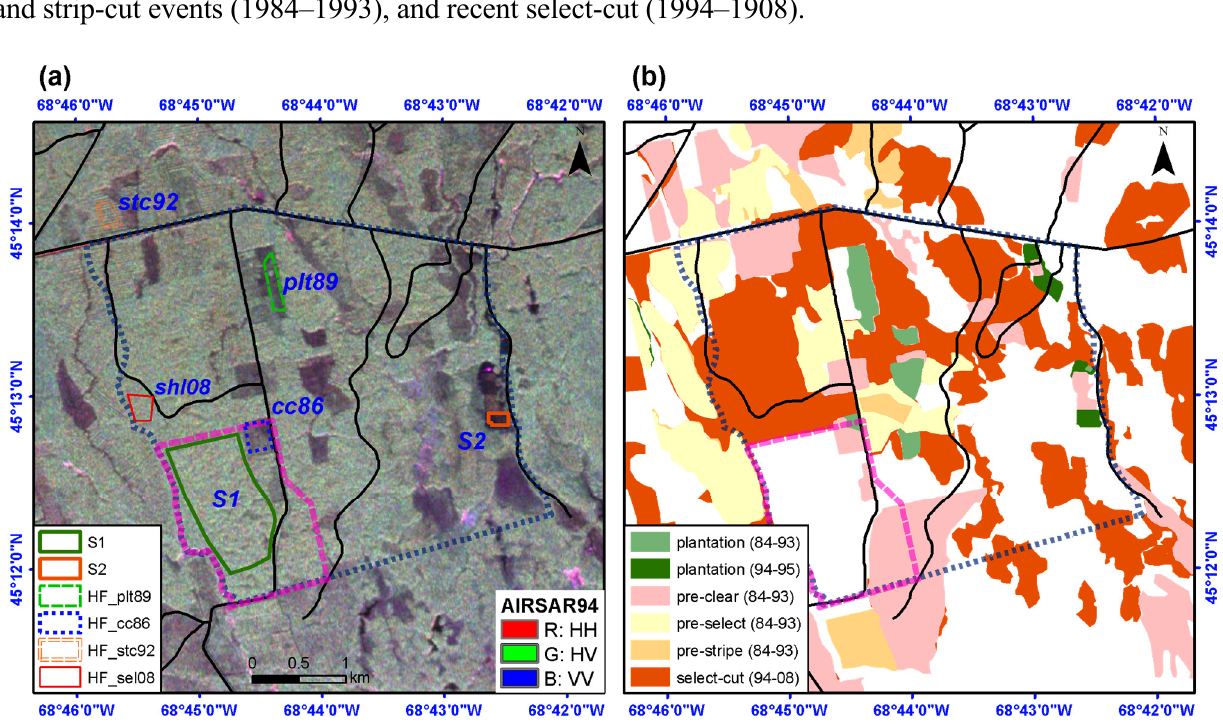
Figure 5. ( a ) Selected plots on AIRSAR image (10/07/1994, R: HH, G: HV, B: VV), and ( b ) Forest management map of the study site. Pink polygon is near-mature forest; dark blue polygon is the outline of the reserve area. Solid line polygons with labels ( i.e. , PLT89 = plantation in 1989; CC86 = clear-cut in 1986; STC92 = strip-cut in 1992; SHL08 = shelterwood harvest in 2008) are the plots selected for sensitivity analysis; S1 is the saturation point in a near-mature forest (biomass > 200 Mg·ha − 1 ); S2 is the maximum soil effect point in a non-forested area (biomass < 10 Mg·ha − 1